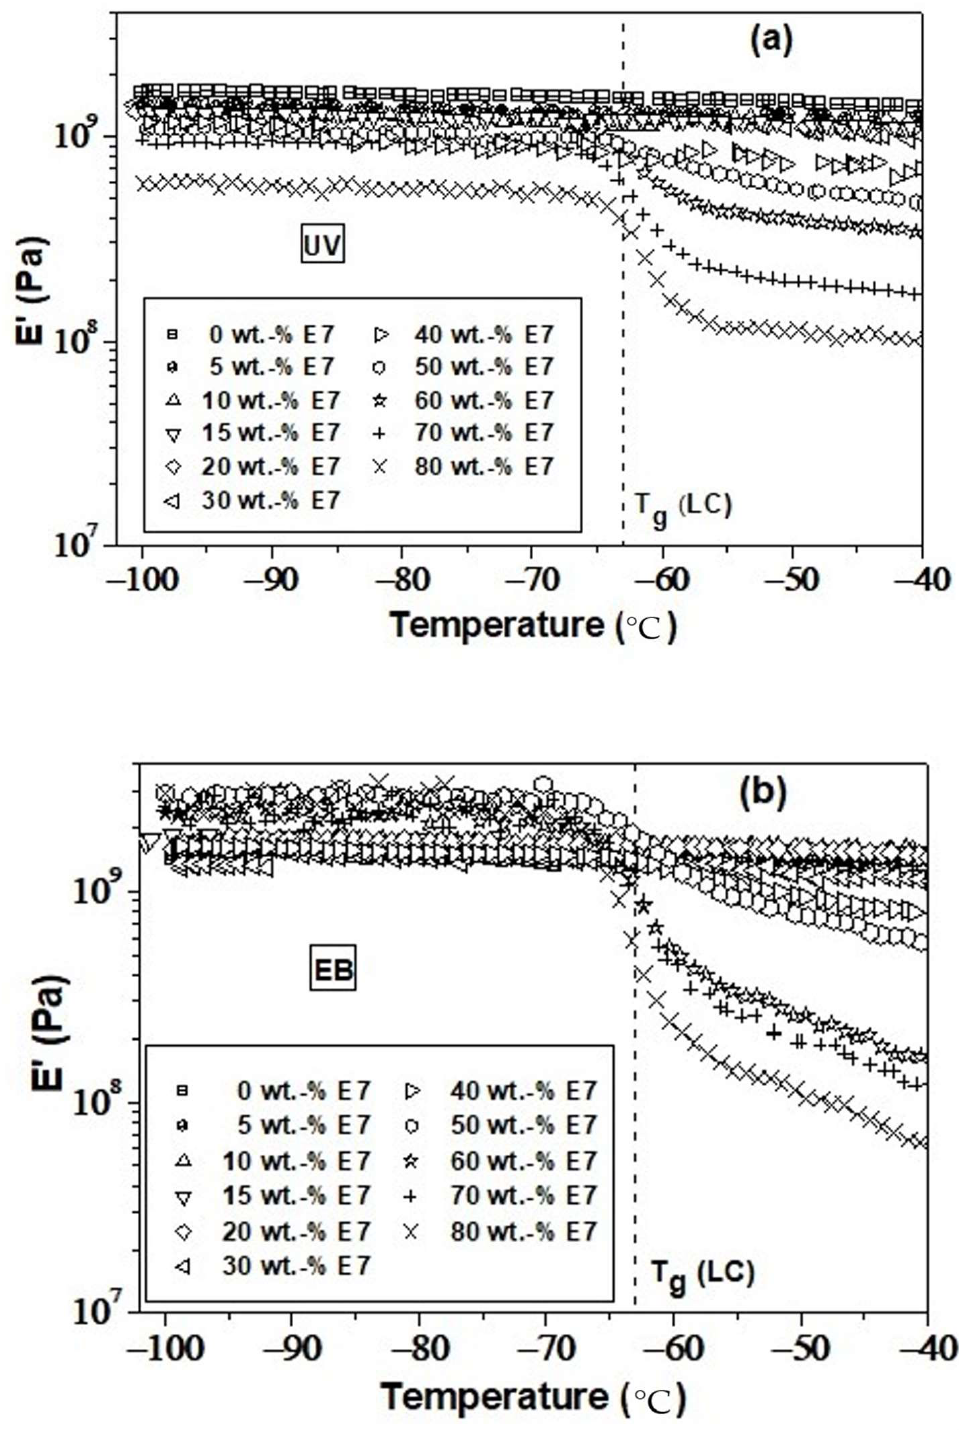
Figure 5. A detailed view of the storage tensile moduli versus temperature in the range from T = − 100 ◦ C to T = − 40 ◦ C. ( a , b ) displays results from EB- and UV-cured TPGDA/E7 films, respectively. The vertical dashed lines represent T g of the pure LC.